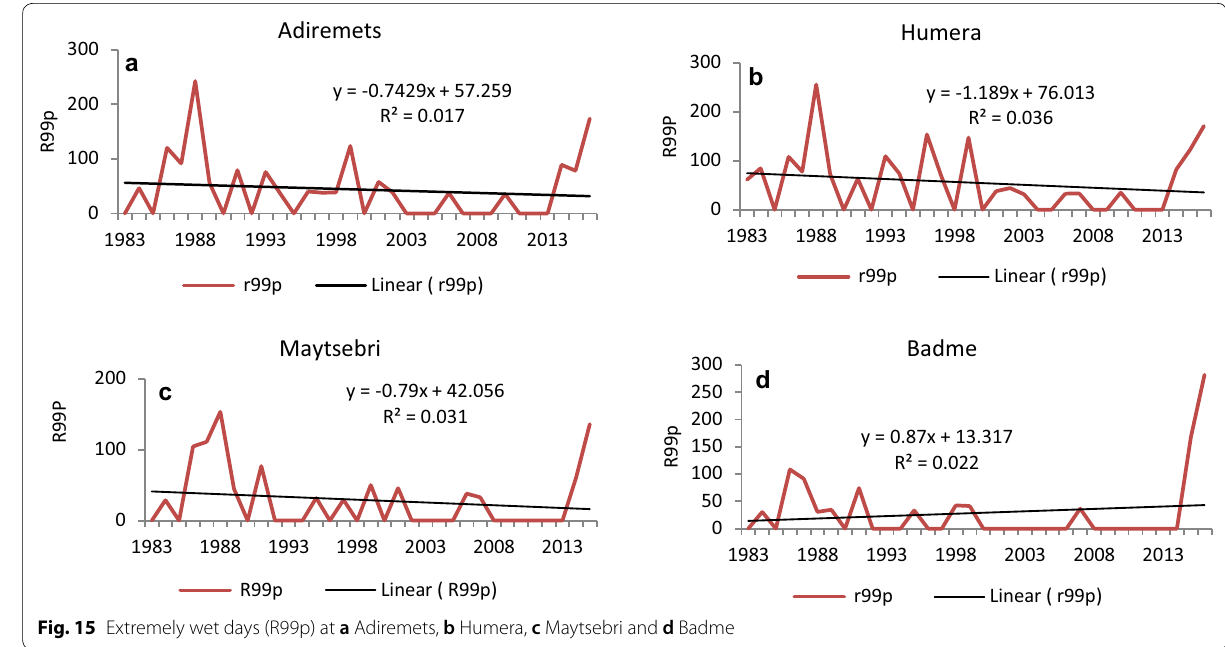
Fig. 15 Extremely wet days (R99p) at a Adiremets, b Humera, c Maytsebri and d Badme